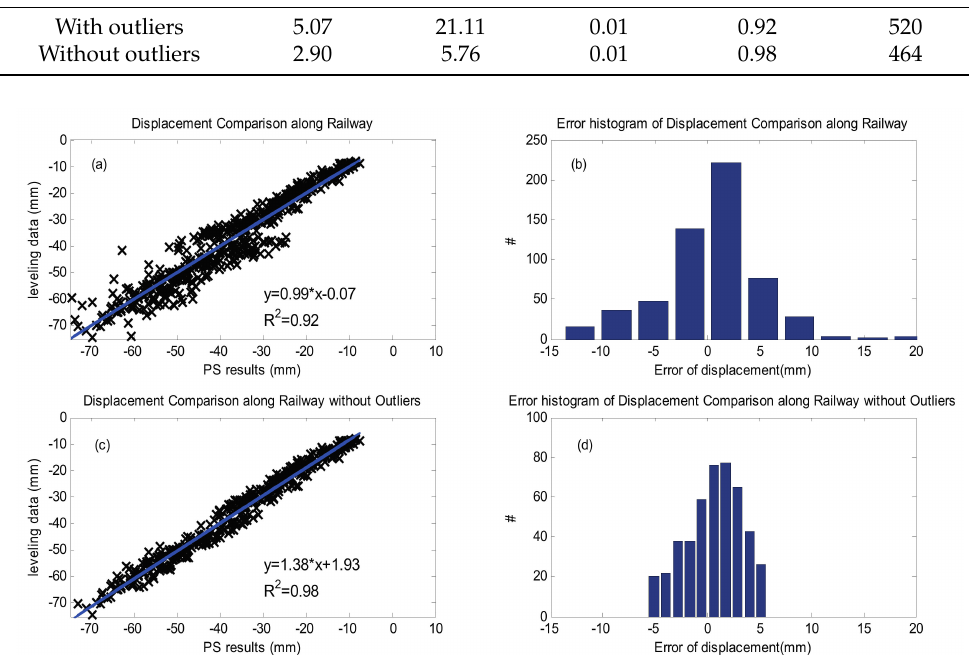
Figure 7. The regression analysis and error histogram of displacement between PS results and leveling measurements along a railway. ( a ) Regression of displacement by using the nearest neighbor method; ( b ) Error histogram of displacement by using the nearest neighbor method; ( c ) Regression of displacement by using the nearest neighbor method without outliers; ( d ) Error histogram of displacement by using the nearest neighbor method without outliers.